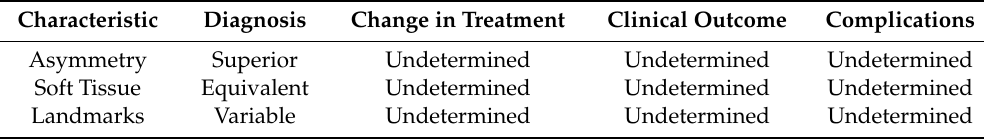
Table 3. Comparison of CBCT to Lateral Cephalograms in Orthognathic Surgery. Characteristic Diagnosis Change in Treatment Clinical Outcome Complications Asymmetry Superior Undetermined Undetermined Undetermined Soft Tissue Equivalent Undetermined Undetermined Undetermined Landmarks Variable Undetermined Undetermined